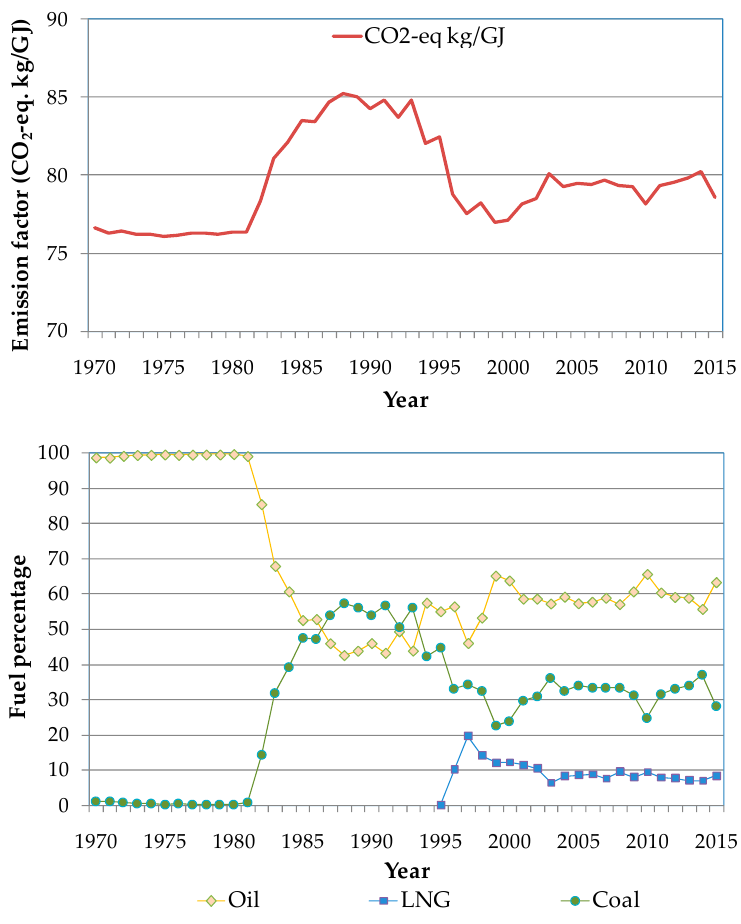
Figure 5. Emission factor and fuel mix from 1970 to 2015 (yearly).